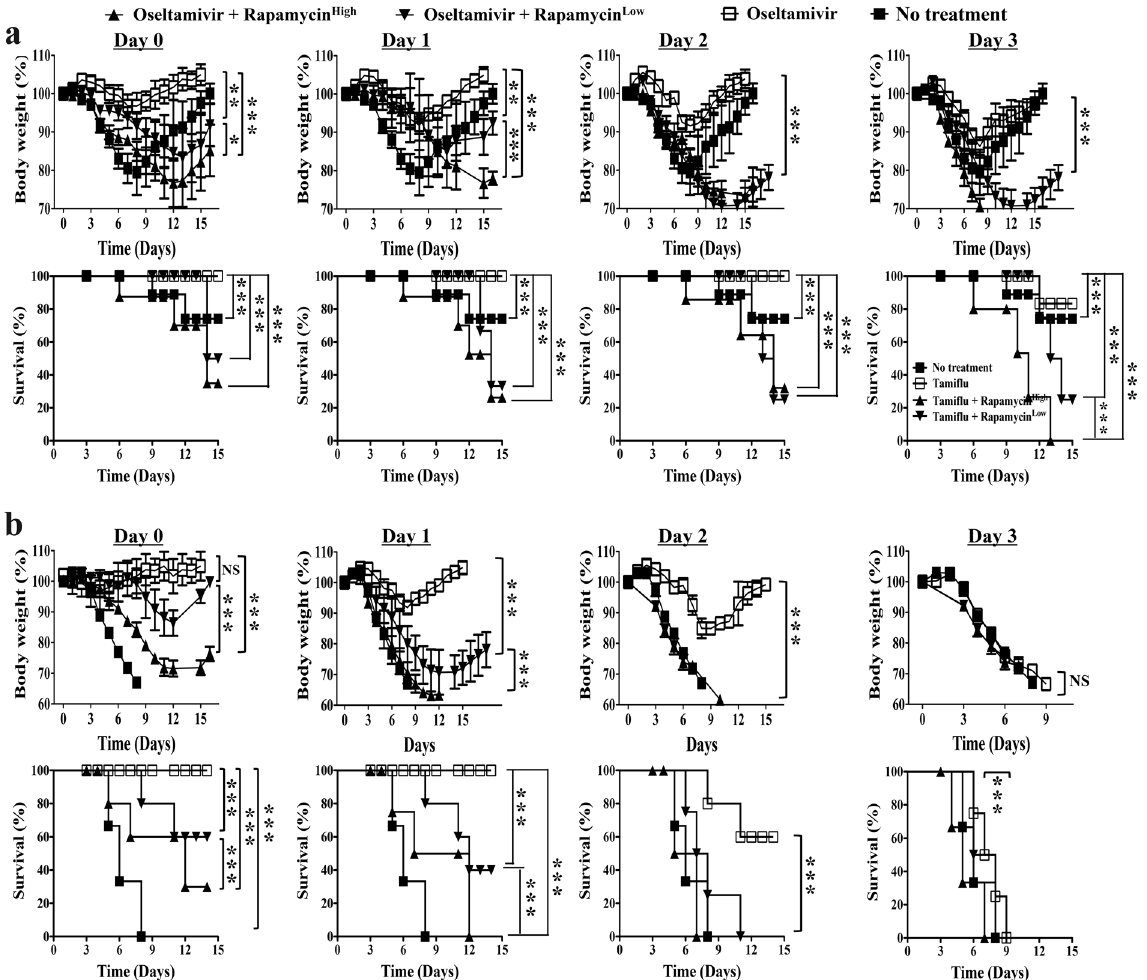
Figure 4. Rapamycin do not salvage severe influenza progressive under Oseltamivir. High (3 mg/kg bodyweight) and low (0.03 mg/kg bodyweight) dose salvage Rapamycin treatment accelerates disease progression and abolishes protective effect of Oseltamivir treatment, regardless of timing of treatment. Naïve BALB/c mice of comparable age were infected with either ( a ) 2.5 × 10 3 PFU or ( b ) 1.25 × 10 4 PFU PR8 influenza virus. Rapamycin and Oseltamivir treatment was started from the stated days post infection and control untreated mice received daily intraperitoneal injection of equal volume placebo solvent and oral feeding of phosphate buffered solution (PBS). Mice with Oseltamivir only served as another control group. Data are representative of at least three similar experiments and presented as mean ± s.d. ( *** p < 0.0001; ** p < 0.001; * p < 0.01; NS = non-significant, p > 0.05; n =